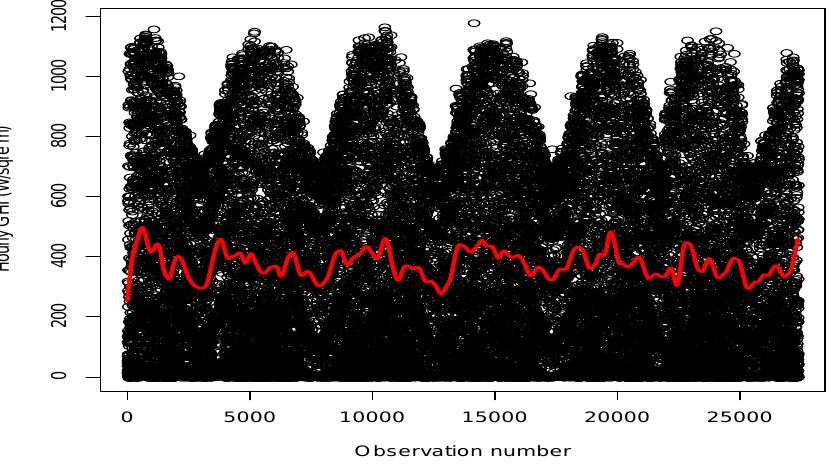
Figure 1. Plot of hourly GHI from 16 November 2015 to 16 November 2021 superimposed with a non-linear